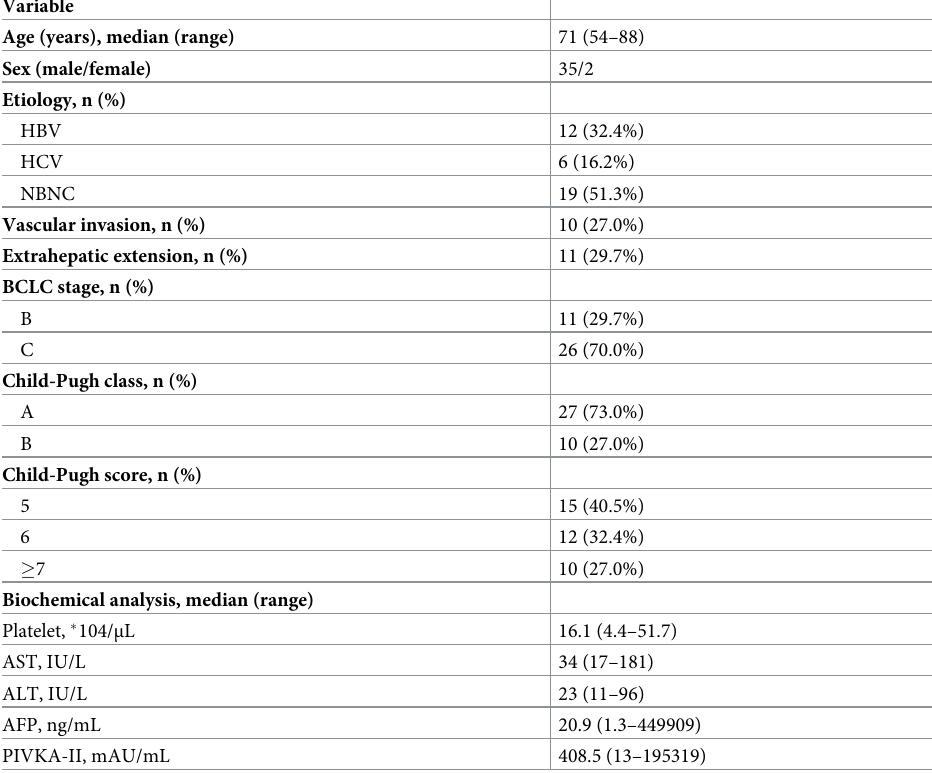
Table 1. Baseline patient